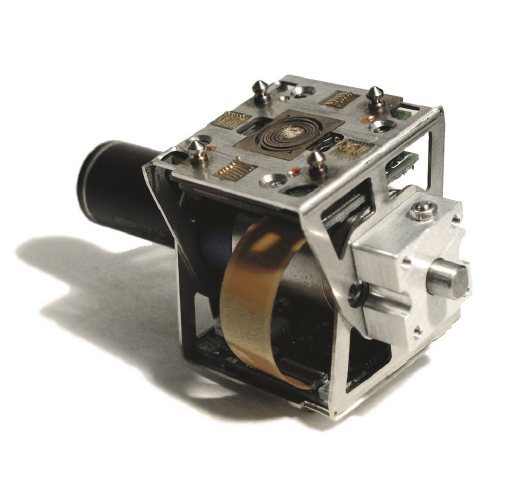
Figure10:PolybotG2MSRR(source:http://elek3ronik.blogspot.in/